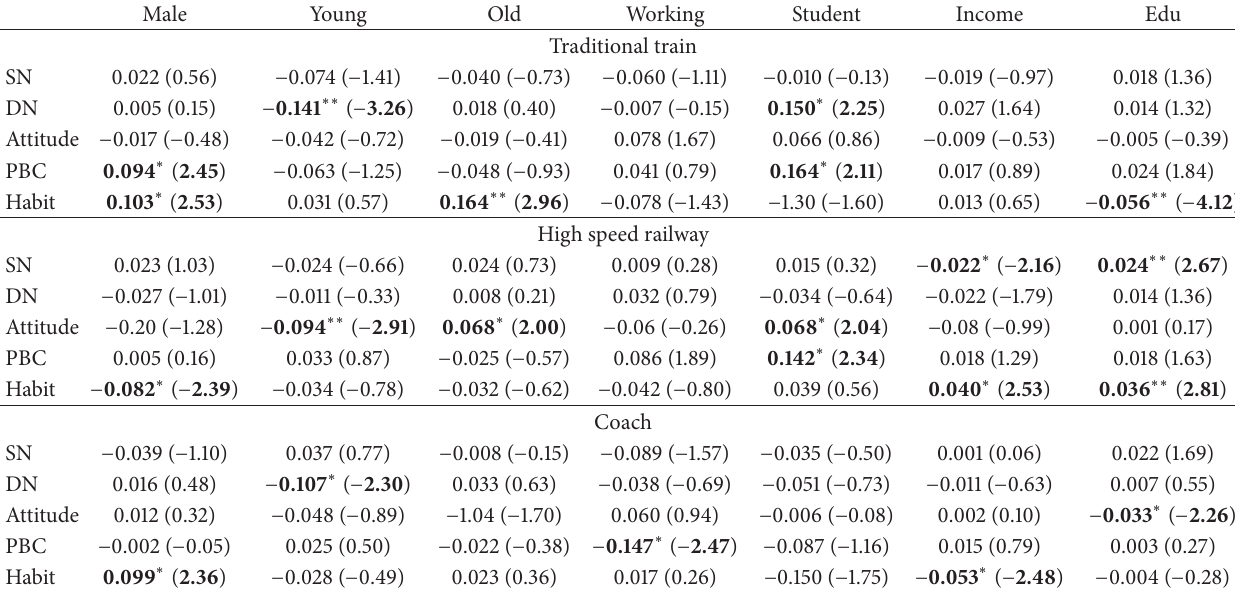
Table 4: Impact of demographical variables on the latent